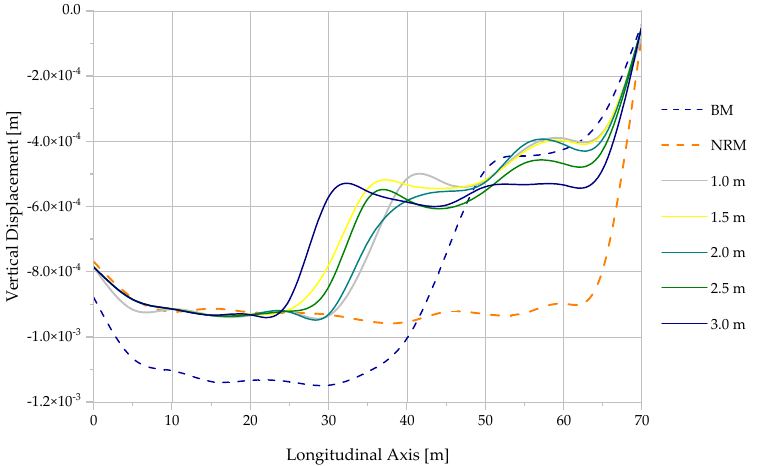
◦ with 25 and 20 BB sleepers per